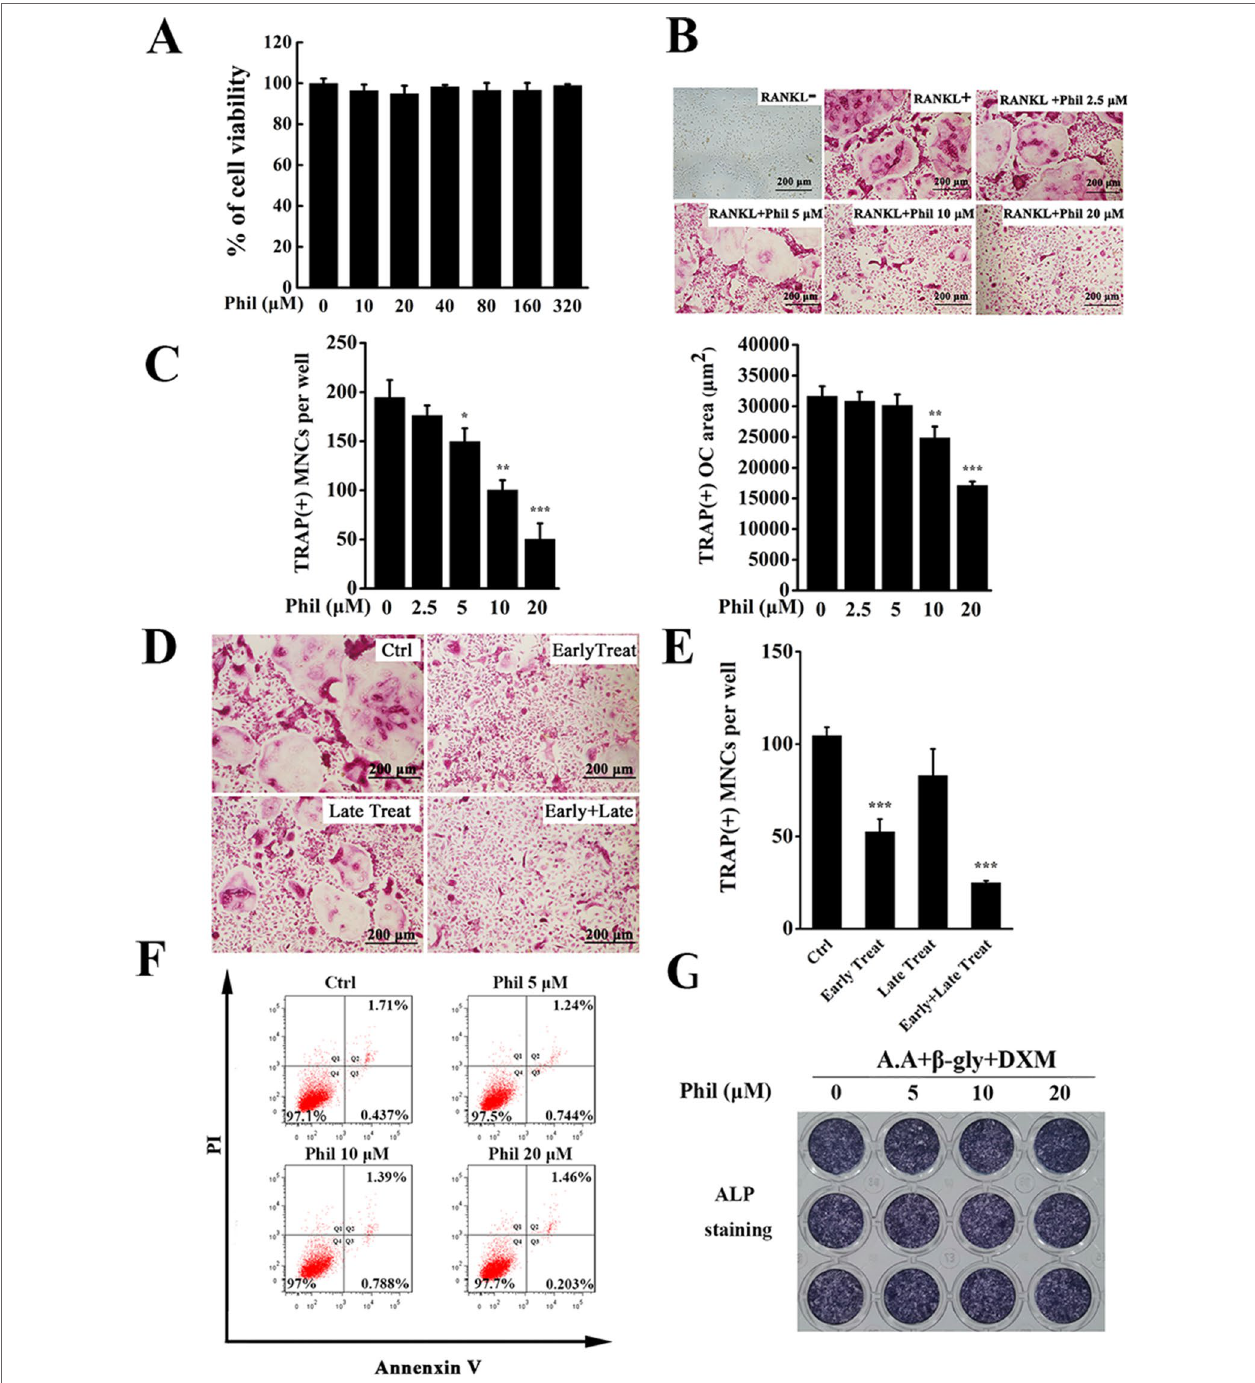
FIGURE 2 | Phil significantly and dose-dependently inhibits RANKL-induced osteoclast differentiation. (A) MTS assay was performed to measure the viability of BMM cells. (B) BMM cells were seeded into 96-well plates and treated with various doses of Phil (0, 2.5, 5, 10, and 20 µM), followed by stimulation with M-CSF (30 ng/ml) and RANKL (100 ng/ml) for 5 days. After fixing with 4% paraformaldehyde, the cells were stained for TRAP activity. (C) The number and area of TRAP + cells (≥3 nuclei) were counted. n = 3, * P < 0.05, ** P < 0.01 and *** P < 0.001 relative to RANKL-induced, Phil-untreated control. (D) Addition of Phil (10 µM) at different differentiation time points (Ctrl: RANKL stimulation for 5 days without Phil; Early Treat: coincubation with RANKL and Phil for 2 days and RANKL continuous incubation for another 3 days; Late Treat: RANKL incubation for 2 days and subsequent coincubation with RANKL and Phil for 3 days; Early+Late Treat: coincubation with RANKL and Phil for 5 days). TRAP staining was carried out to quantify the number of TRAP + osteoclasts (≥3 nuclei). The data were shown in (E) . n = 3, *** P < 0.001 relative to control. (F) After treating the cells with varying doses of Phil (0, 5, 10, and 20 µM) for 24 h, flow cytometry was used to detect apoptosis. (G) Human osteoblasts (hFOB 1.19) were treated with different concentrations of Phil in the presence of ascorbic acid (A.A), β -glycerophosphate ( β -gly), and dexamethasone (DXM) for 10 days. The cells were fixed with 4% paraformaldehyde and then stained for alkaline phosphatase (ALP)